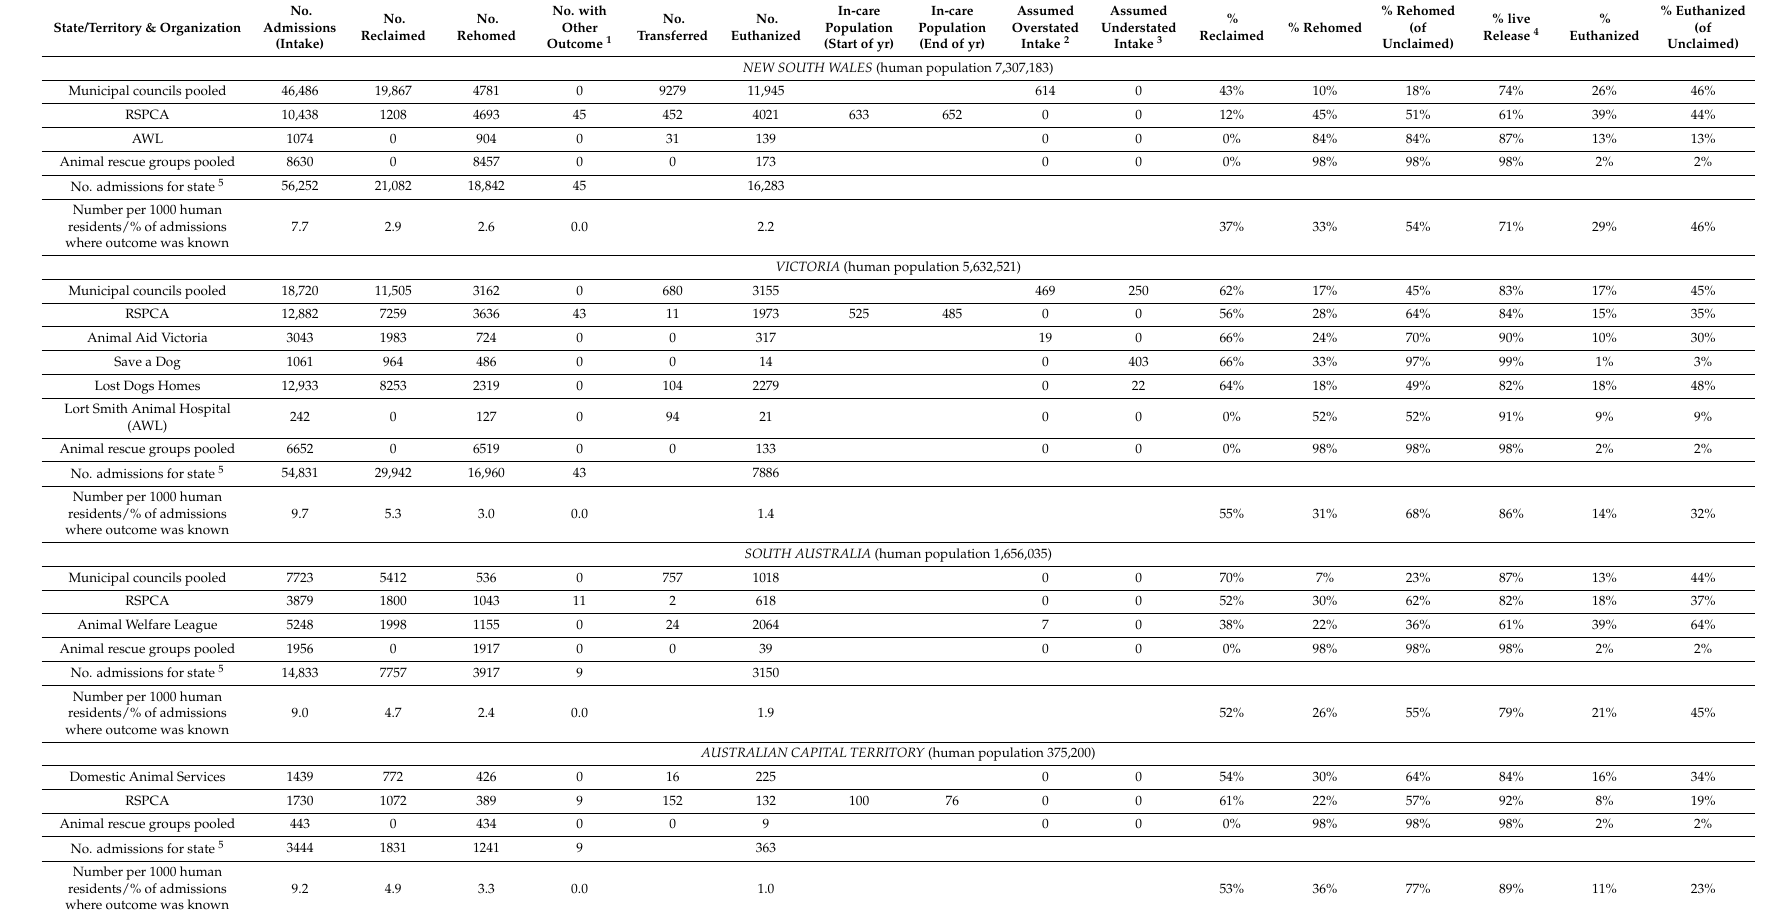
Table 1. Council pound and shelter statistics by